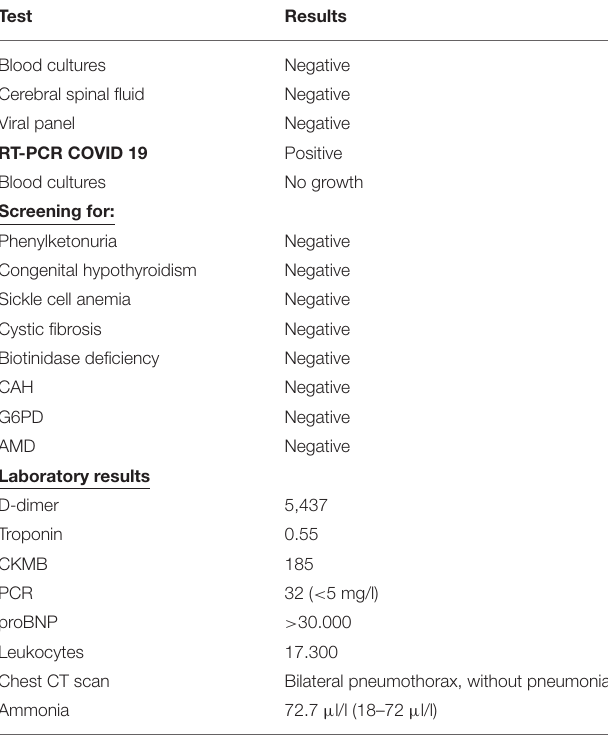
TABLE 1 | Laboratorial results during the patient’s admission.